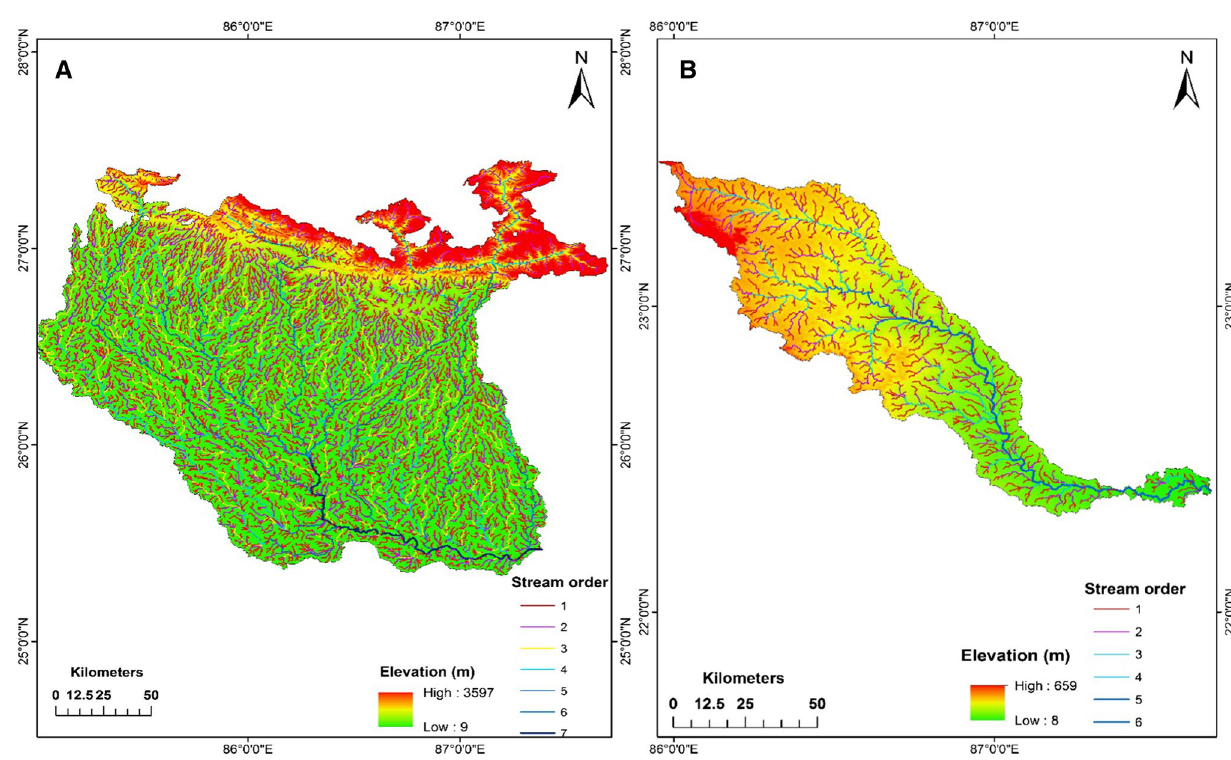
Fig. 4 Linear aspects of River basin morphometry a Kosi and b